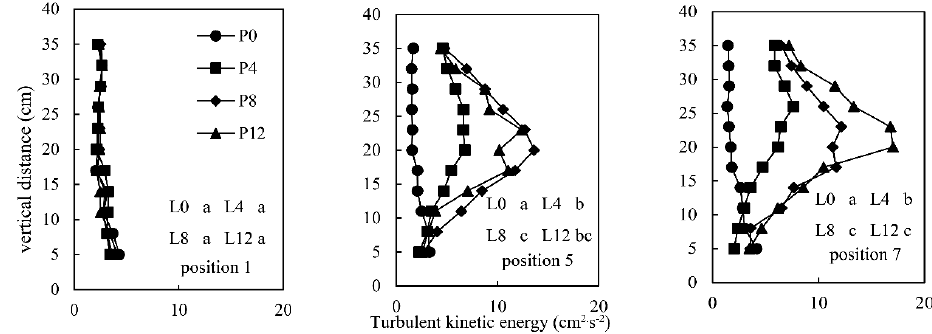
Figure 8. Turbulent kinetic energy under L0, L4, L8, and L12 (note: values within a position followed by the same letter are not significantly different (LSD, p < 0.05)).